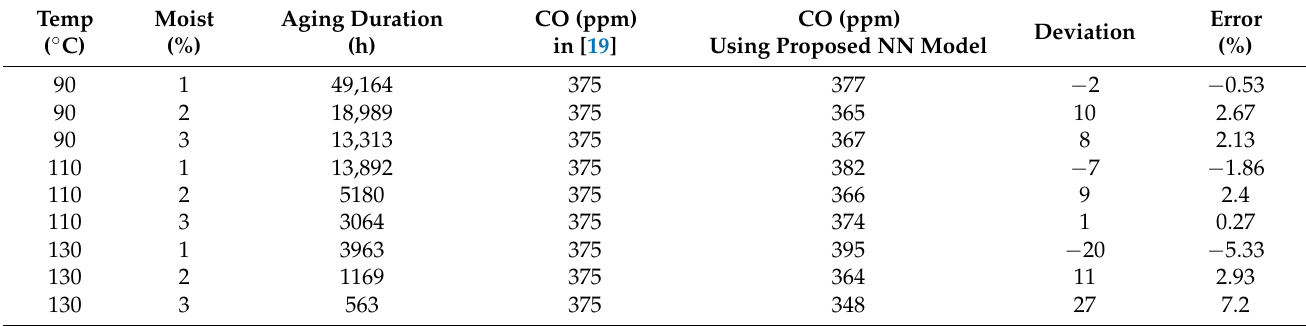
Table 5. Comparison of estimated life using neural network by treating CO as a failure